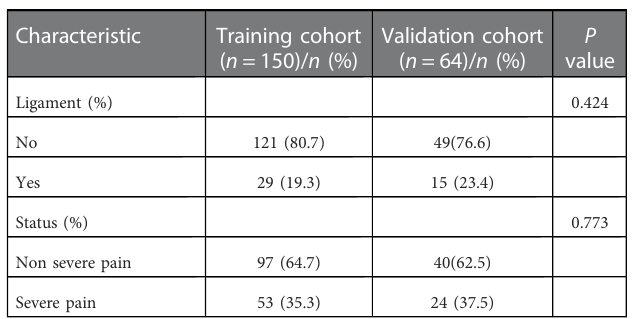
TABLE 1 Patient demographic characteristics of the modeled